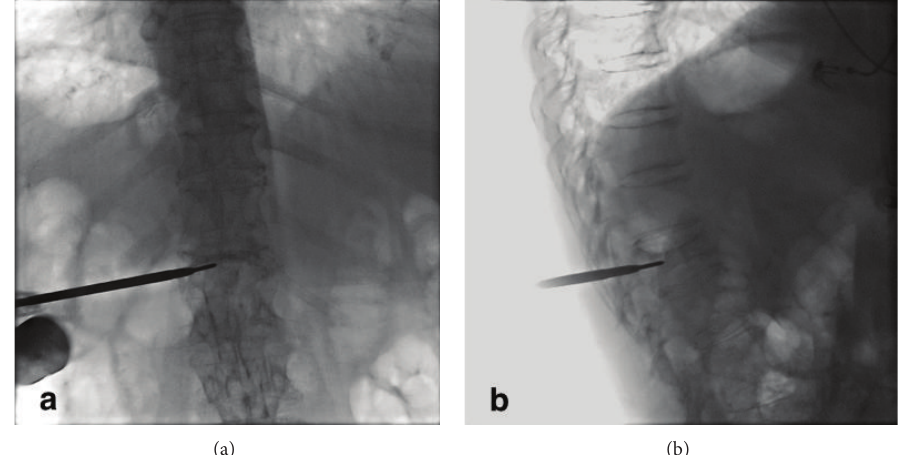
Figure 2: Orthogonal fluoroscopic projections allowed adequate detection of vertebral pedicles of T10 vertebrae for placement of kyphoplasty and vertebroplasty systems.